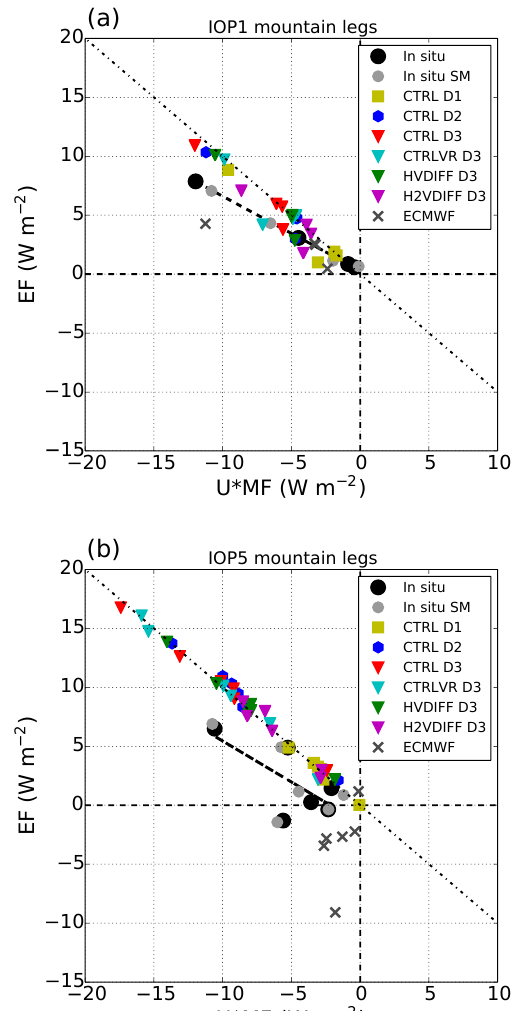
Figure 14. Leg-averaged Eliassen–Palm relation between energy flux (EF) and momentum flux (MF) multiplied by leg-averaged horizontal wind speed U along all flight legs during (a) IOP1 and (b) IOP5 for observed and simulated data at flight level. The dash– dotted line marks the identity line and the thick dashed line indicates the linear regression of observed data. The grey dots (In-situSM) mark observed data for wavelengths larger than 15km. To exclude effects of non-orographic GWs, only data directly over the moun- tains are utilized (see Fig. 2 for leg locations).